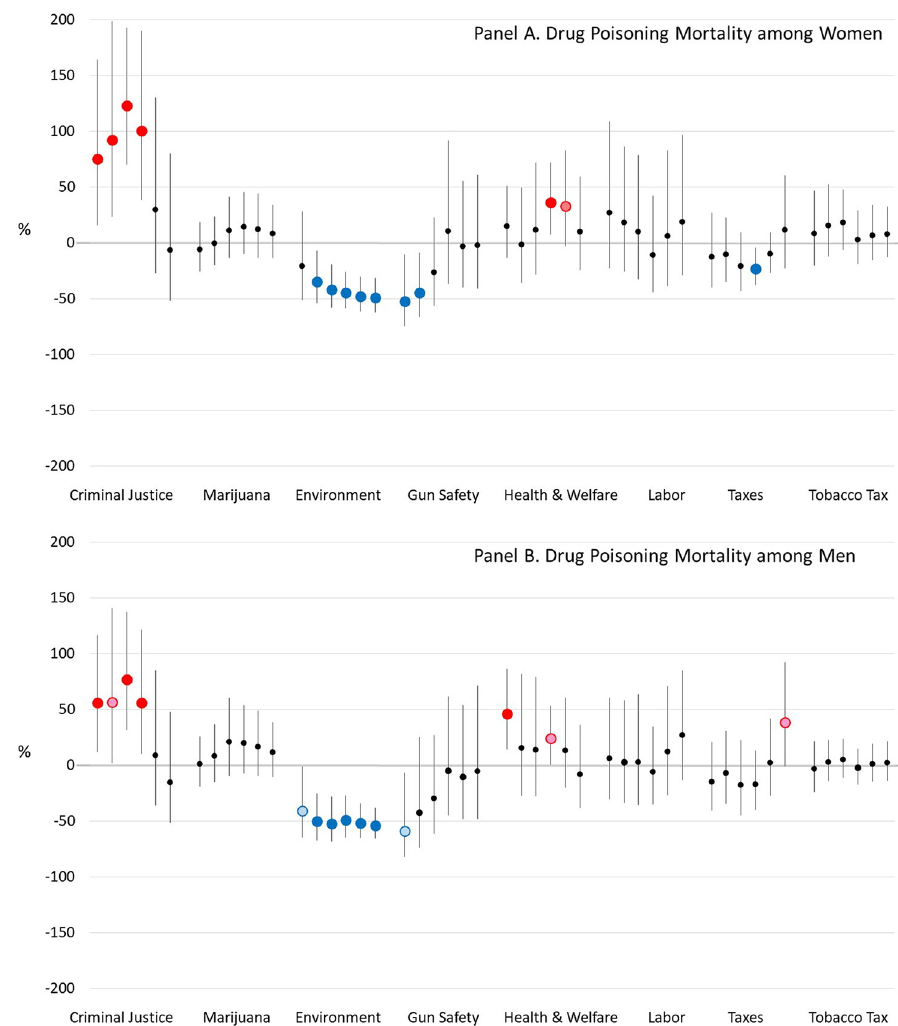
Fig 6. Estimated percent difference in drug poisoning mortality rates when a U.S. State’s policy liberalism score is 1 versus 0, for various lag times between the policies and mortality. Notes : Blue dots mean a more liberal version of the policy is associated with lower mortality and red dots mean a more conservative version is associated with lower mortality. Dark blue and red dots indicate that the association is significant at α < 0.05, while light blue and red dots indicate that it is significant at α <